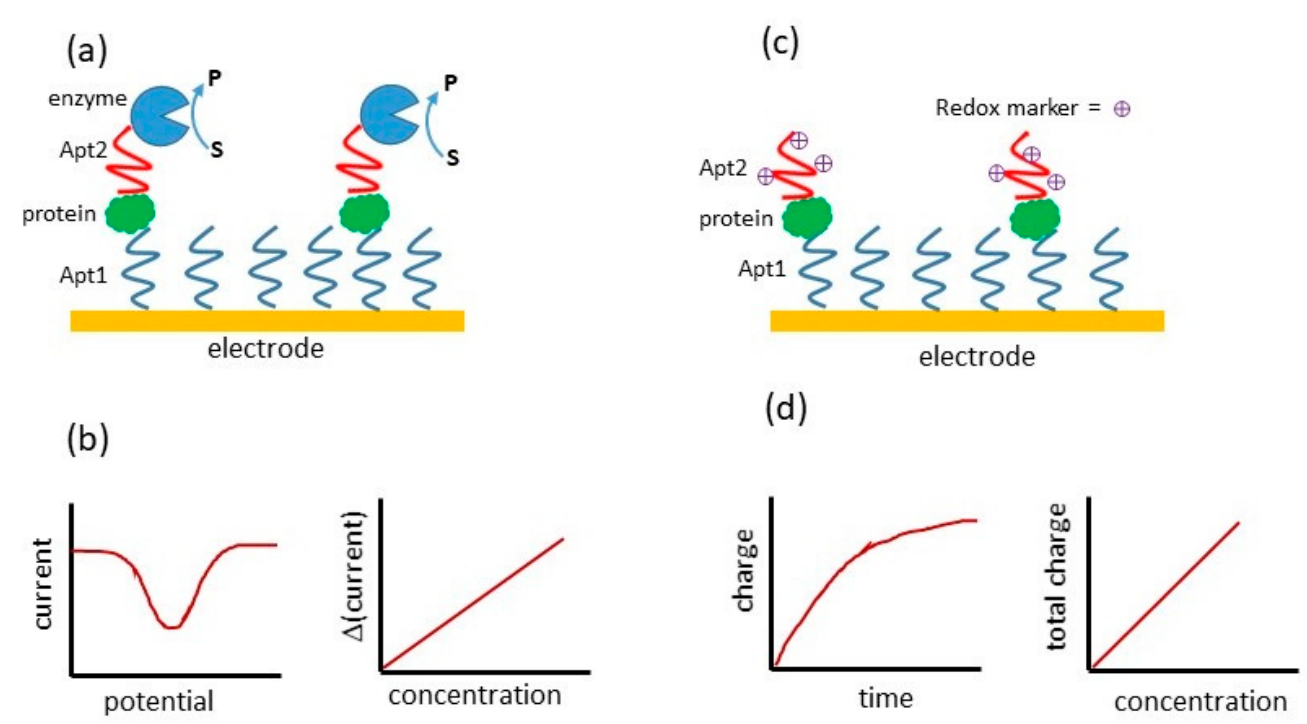
Scheme 2. The basic architectures for electrochemical sandwich assays consisting of a capture aptamer (Apt1) and a detection aptamer (Apt2). In the scheme shown in ( a ), the detection aptamer is bound to an enzyme and the enzyme product is detected using differential pulse voltammetry, with the difference in current in the presence and absence of protein plotted versus analyte concentration over the linear range, as shown in ( b ). In the scheme shown in ( c ), a redox marker binds electrostatically to the detection aptamer and is detected using chronocoulometry which measures charge vs. time in the initial measurement with total charge passed plotted vs. analyte concentration over the linear range, as shown in ( d